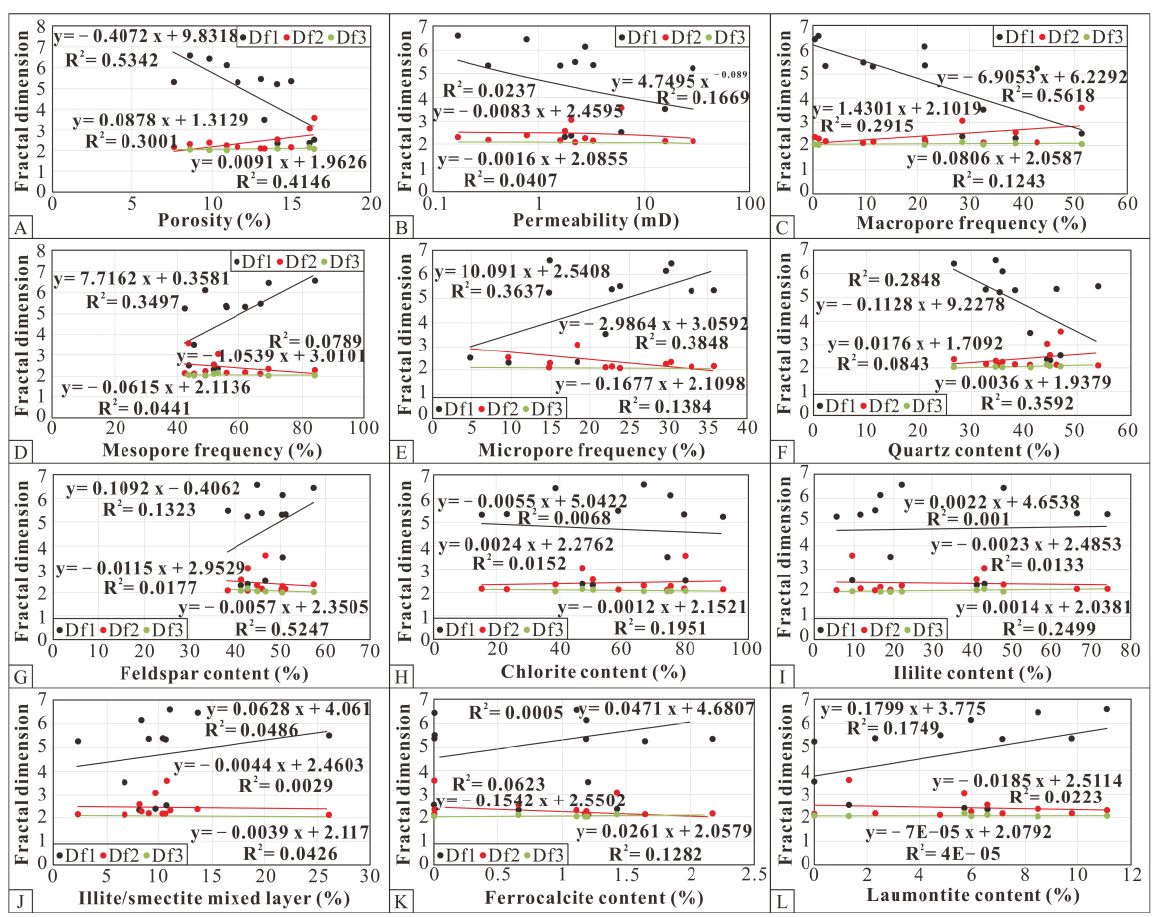
Figure 19. Correlation of multifractal dimensions with physical properties and mineral composition. ( A , B ) Correlation between physical properties and fractal dimension. ( C ) Correlation between macropore frequency and fractal dimension. ( D ) Correlation between mesopore frequency and fractal dimension. ( E ) Correlation between micropore frequency and fractal dimension. ( F ) Correlation between quartz content and fractal dimension. ( G ) Correlation between feldspar content and fractal dimension. ( H ) Correlation between chlorite content and fractal dimension. ( I ) Correlation between illite content and fractal dimension. ( J ) Correlation between I/S mixed layer content and fractal dimension. ( K ) Correlation between ferro-calcite content and fractal dimension. ( L ) Correlation between laumontite and fractal dimension.